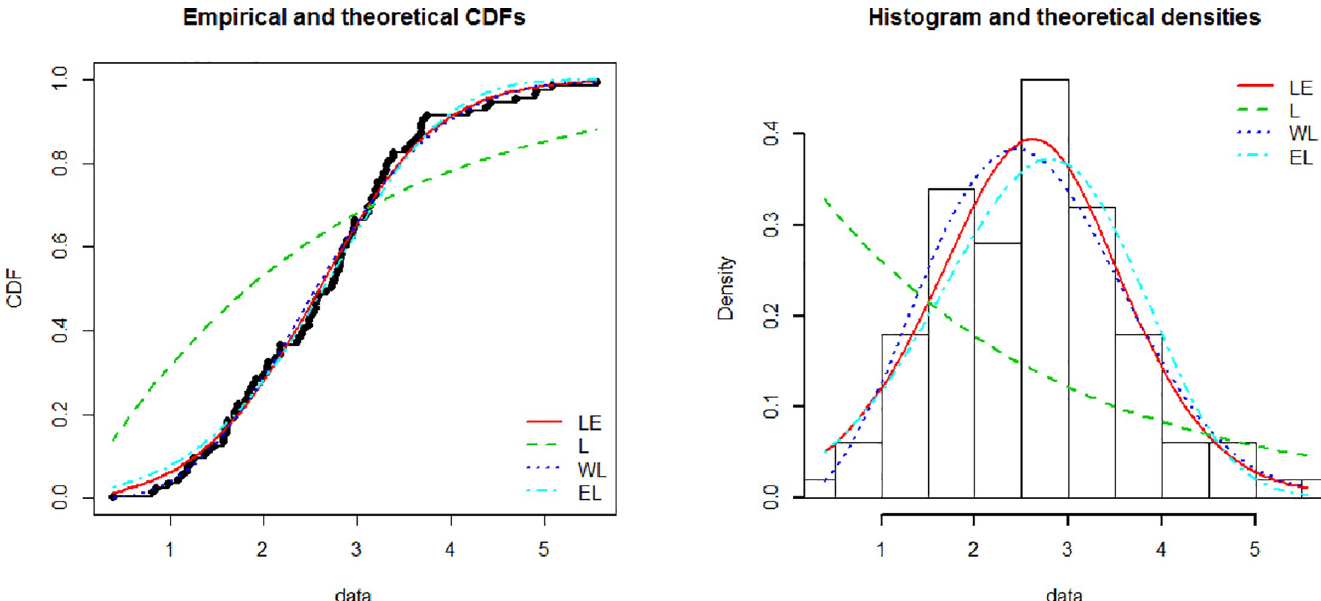
Fig 5. Theoretical and empirical Pdf and Cdf of LE for data set